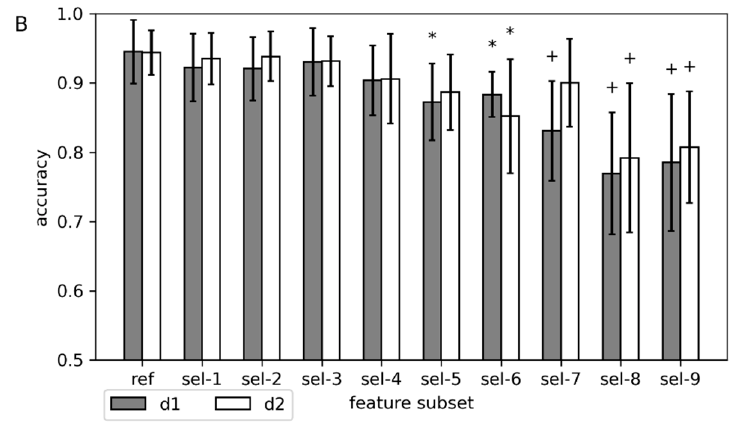
Figure 8. Feature importance and feature selection with RFC. ( A ) Feature importance calculated by MDI averaged over the six different data splits (one for each run) for RFC trained on first derivative data. ( B ) Classification accuracy after removal of features averaged over the six different data splits (one for each run), weighted by the number of samples in each run. Feature selection strategies are listed in Table 1. Significant difference in average accuracy to the reference (ref) is denoted by * ( p < 0.05) or + ( p < 0.01).